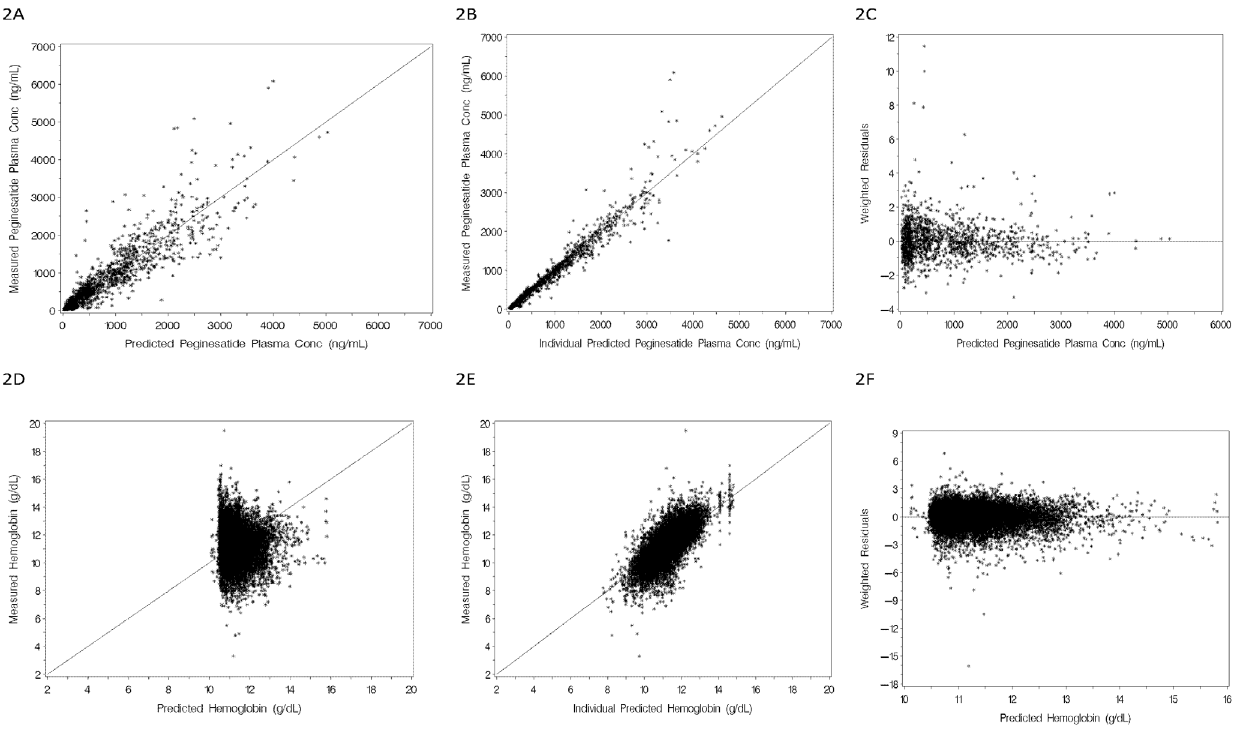
Figure 2. Diagnostic goodness-of-fit plots for the final population PK model of peginesatide (2A-C:upper panel set) and for the final population PK-PD model of peginesatide (2D-F: lower panel set). Upper left (2A): measured concentration versus predicted concentration; Upper middle (2B): measured concentration versus individual predicted concentration; Upper right (2C): weighted residuals versus predicted concentration. Lower left (2D): measured hemoglobin versus predicted hemoglobin; Lower middle (2E): measured hemoglobin versus individual predicted hemoglobin; lower right (2F): weighted residual versus predicted hemoglobin concentration. doi:10.1371/journal.pone.0066422.g002 PLOS ONE |